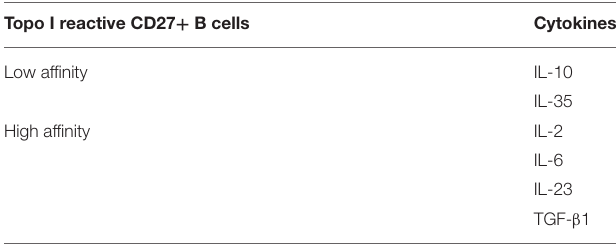
TABLE 3 | Effects of B cell depletion treatment on the cytokine profile measured at the skin and spleen of TSK/ +